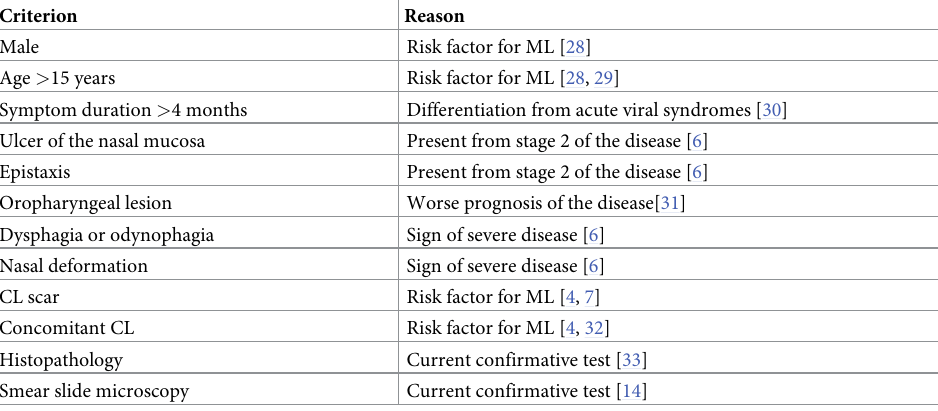
Table 2. Twelve rurally available clinical criteria assessed for diagnostic accuracy in this